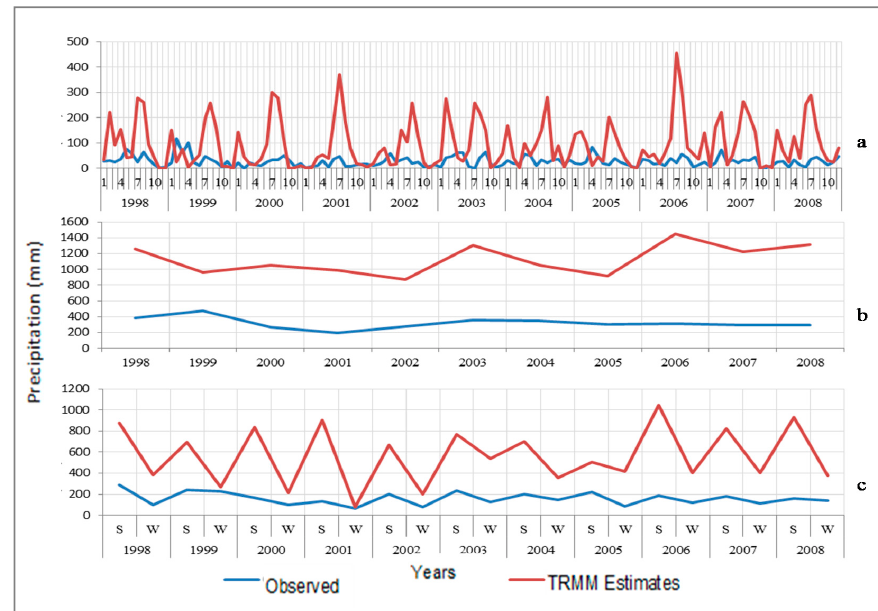
Figure 2. Time series of TRMM estimates and gauge data for rainfall totals at Yasin station; ( a ) monthly, ( b ) annual, and ( c ) seasonal (S = summer, W = winter). Climate 2018 , 6 , x FOR PEER REVIEW